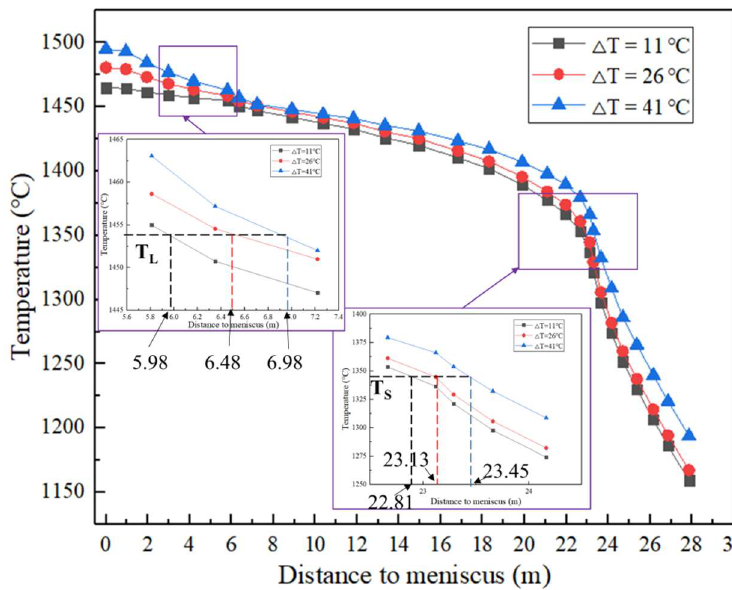
Figure 6. Effect of superheat on the center temperature of bloom.